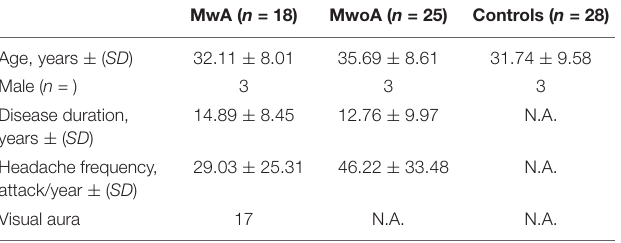
FIGURE 2 | White matter alterations in MwA compared to MwoA. Tract-TBSS indicate increased FA in MwA compared to migraine without. The color bar shows the z-scores of the corrected p -values. The boxplot shows the MD parameters depicted from the affected areas, the central mark is the median and the boxes represent the 25 and 75% percentiles.